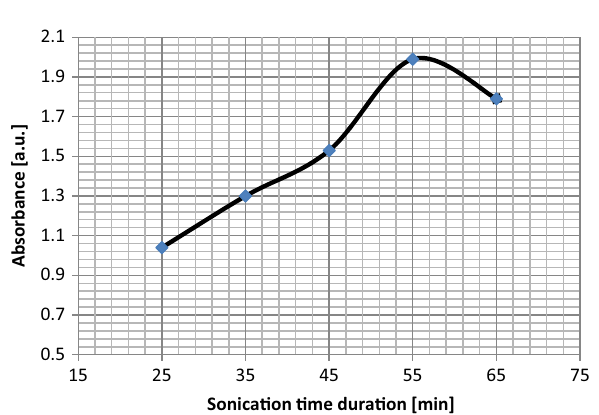
Figure 7. The UV–visible absorption spectrum for the exfoliated graphene for 264 W power versus different sonication time durations.